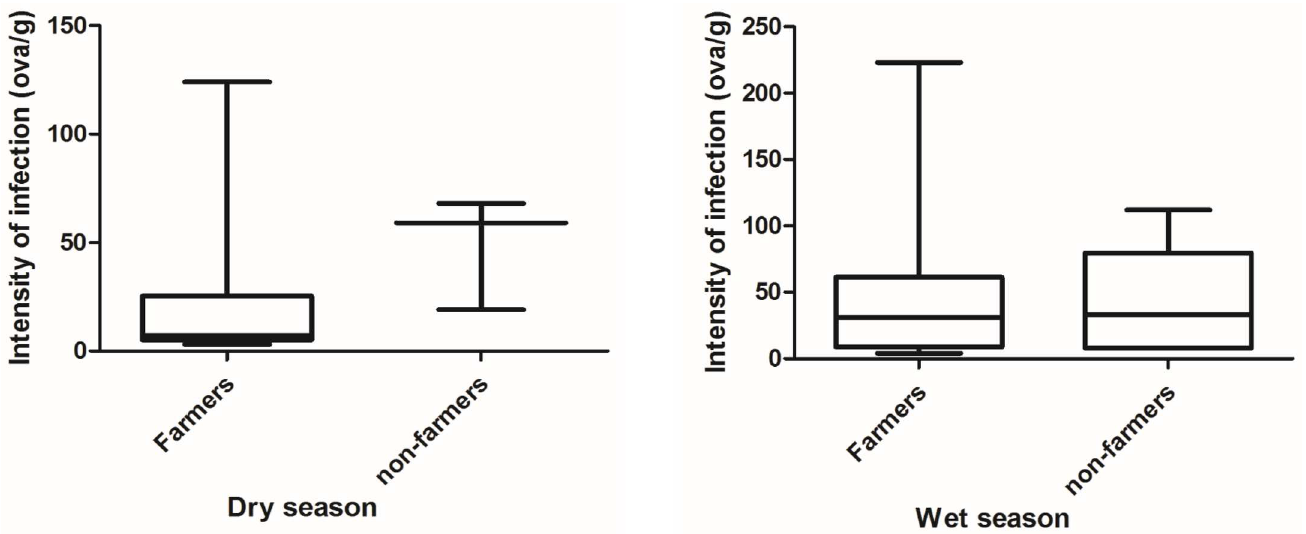
Fig 4. Distribution of Ascaris spp for farmersand non-farmers in both